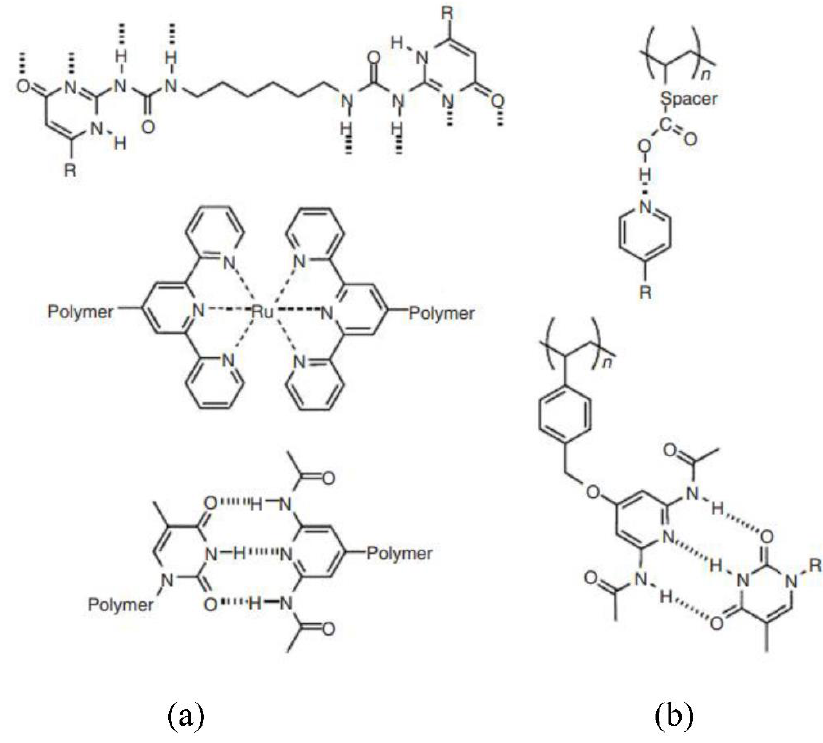
Figure 8. ( a ) Main chain SP ( b ) side chain SP [86].